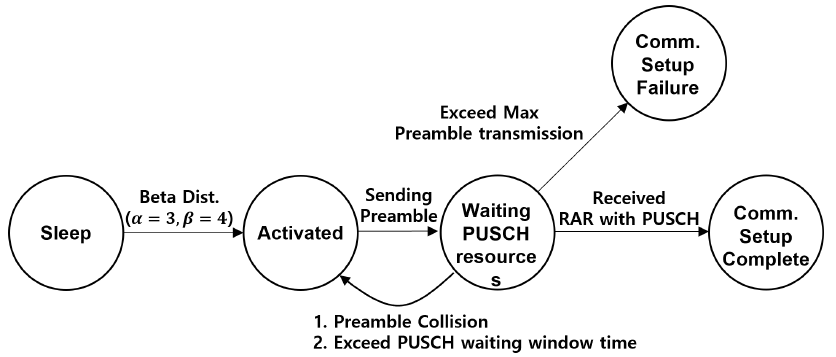
Figure 2. State transition diagram of an IoT device.